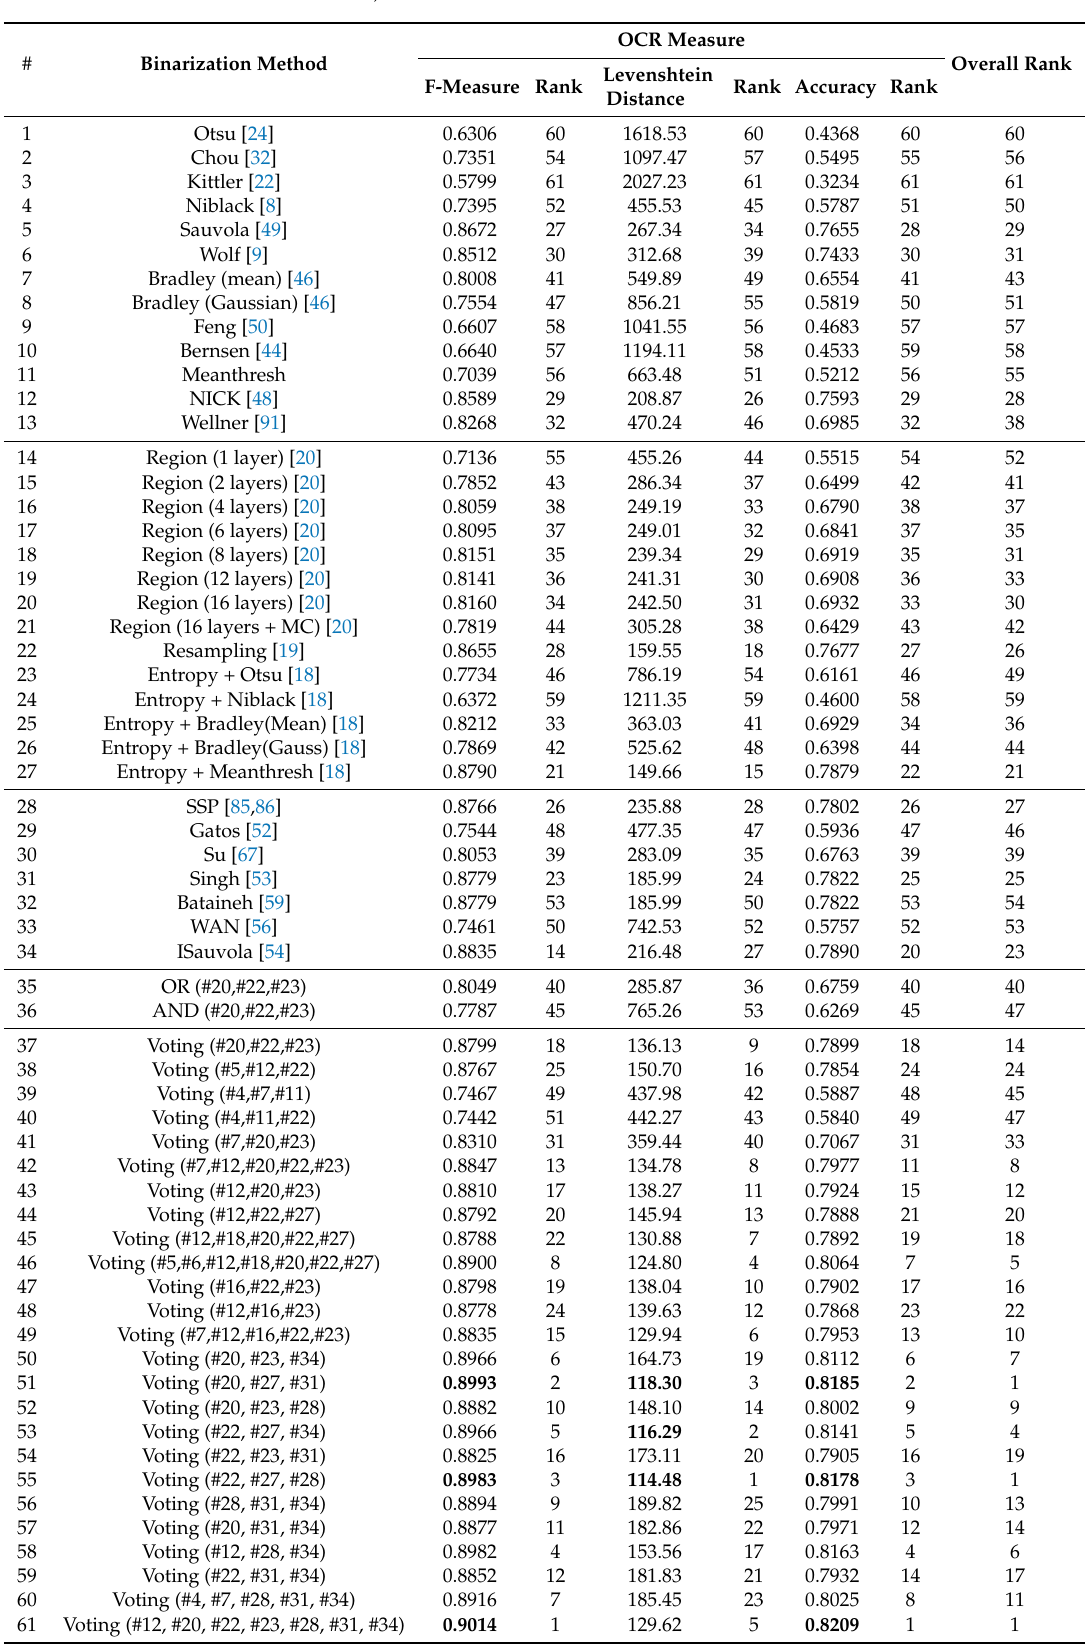
Table 2. Comparison of the average F-measure, Levenshtein distance, and OCR accuracy values obtained for various binarization methods using MATLAB’s built-in OCR engine for 176 document images (three best results shown in bold